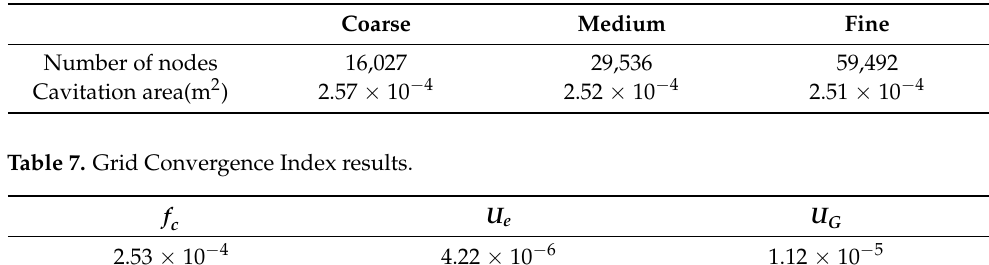
Table 6. Grid test results.